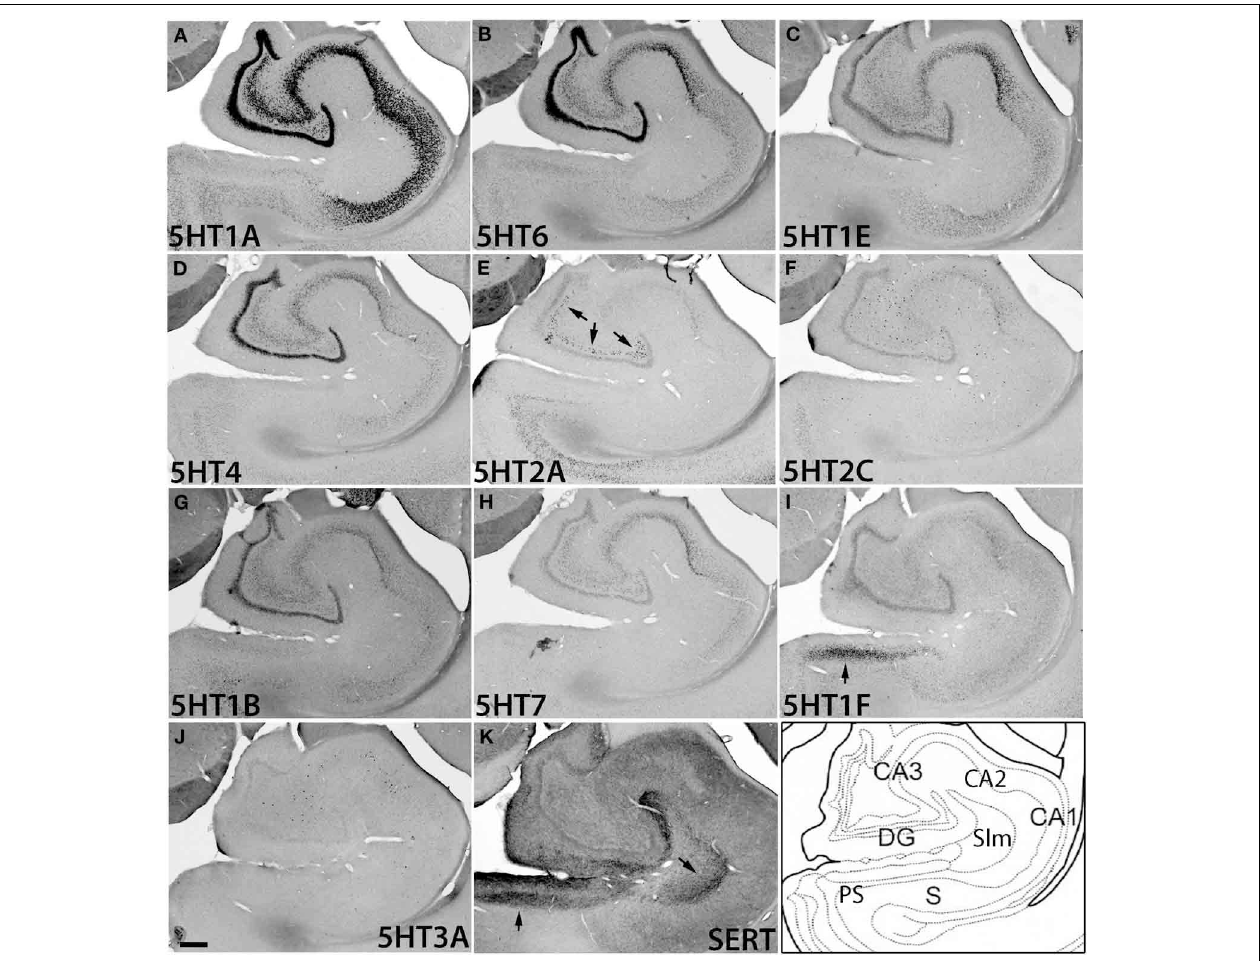
FIGURE 6 | ISH expression profiles of 5HTR s in hippocampus. 5HTR mRNA expressions (A – J) and immunohistochemical staining with anti-SERT antibody (K) in CA1 and CA3 fields, dentate gyrus (DG), presubiculum (PS), subiculum (S), and stratum lacunosum moleculare (Slm) of hippocampal